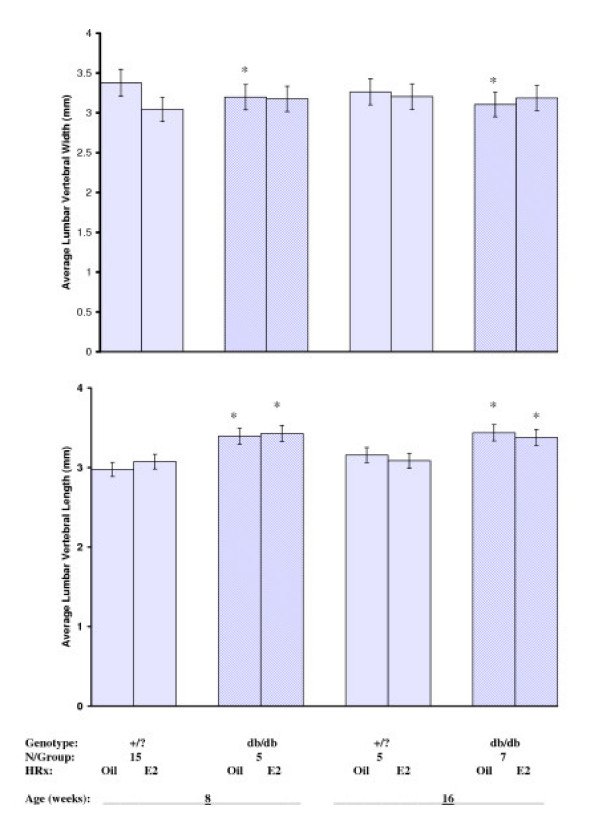
Influences on control (+/?) and diabetes (db/db)-mutant C57BL/KsJ group average lumbar vertebrae (LV) length and width indices following oil- or E2-HRx regimes at 8 and 16 weeks of age. All values are denoted as groups means (± SEM), with significant (P ≤ 0.05) intergroup (i.e. control v.s. diabetes genotypes for indicated HRx regimes) differences are denoted by asterisks (*)